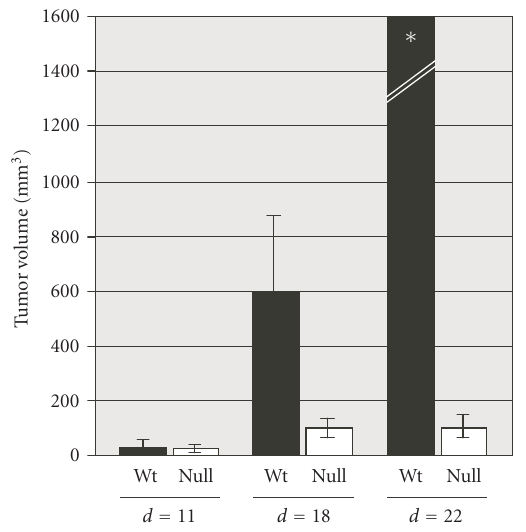
Figure 1: Growth of subcutaneous Lewis lung carcinoma (LLC1) in syngeneic Pparb + / + and Pparb − / − mice. Tumor sizes were deter- mined at the times indicated with a caliper. The calculated volumes are shown as mean ± SD [31]. ∗ All tumor volumes < 1000mm 3